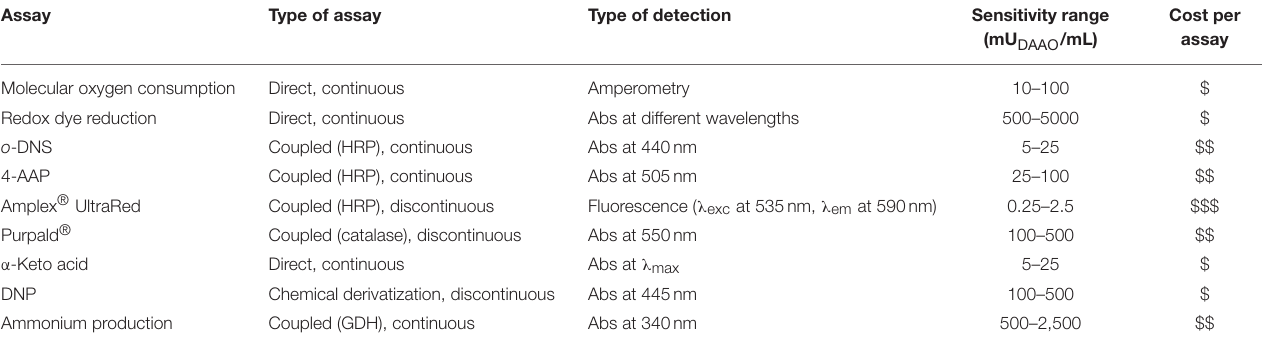
TABLE 3 | Comparison of different assays of DAAO